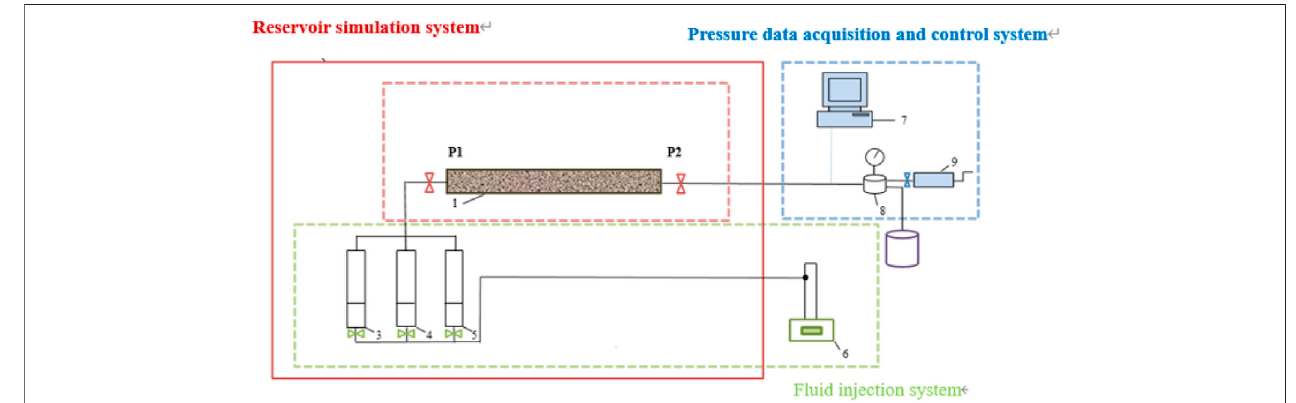
FIGURE 1 | Schematic diagram of the LSF experimental device.